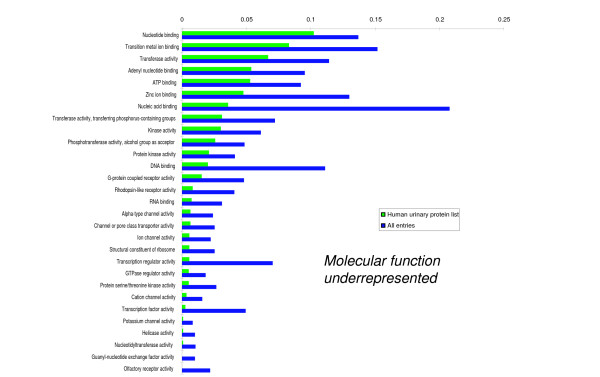
Significantly under-represented GO molecular function terms for the set of identified urinary proteins. Each term was selected as described in the legend of Figure 6. GO, Gene Ontology.